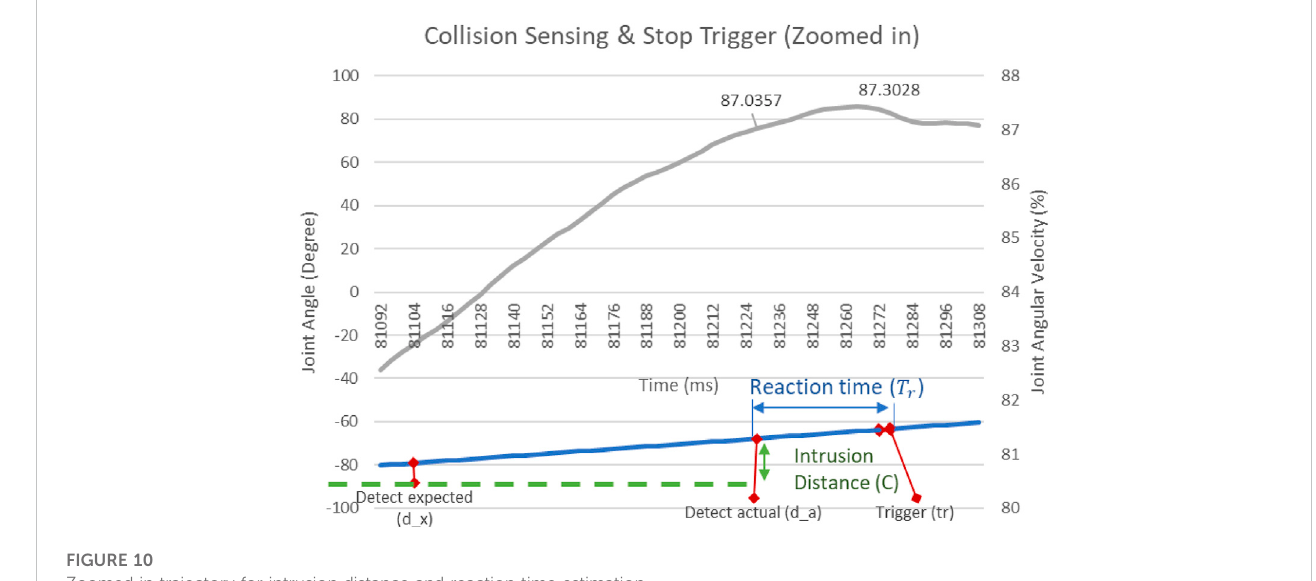
FIGURE 10 Zoomed in trajectory for intrusion distance and reaction time estimation.